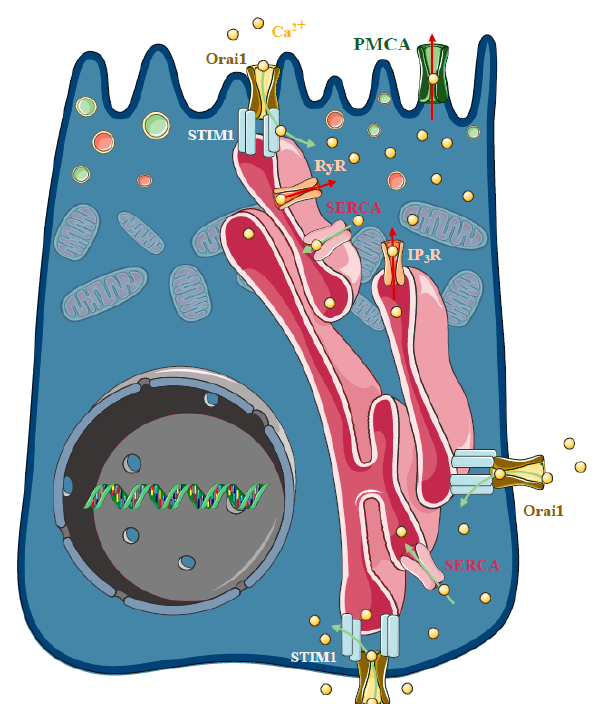
Figure 4. Store-operated Ca 2+ entry and acute pancreatitis. In pancreatic acinar cells physiological agonist stimulation releases Ca 2+ from the endoplasmic reticulum (ER) stores at the apical granular region of the cell. The spatiotemporal localisation of IP 3 -evoked apical signals is maintained by the mitochondria surrounding the apical region of the acinar cells, whereas the plasma membrane Ca 2+ ATPase (PMCA) pumps extrude the Ca 2+ at the apical membrane. The influx of extracellular Ca 2+ in non-excitable cells is mediated by a process called store-operated Ca 2+ entry (SOCE), which is determined by the ER Ca 2+ sensor stromal interaction molecule 1 (Stim1) and the plasma membrane Ca 2+ channel Orai1. In unstimulated cells, Stim1 is distributed in the ER membrane, whereas mobilisation of the ER Ca 2+ stores induces a conformational change and translocation with puncta formation, of Stim1 to the ER–PM junctions, which activates Orai1. The basal Ca 2+ uptake can refill the apical Ca 2+ stores by a mechanism called Ca 2+ tunnelling. Under pathological conditions, the spatiotemporal regulation of the Ca 2+ signalling fails and extracellular Ca 2+ entry is an important contributor to the Ca 2+ toxicity. Recently, an Orai1 channel regulator protein called store-operated calcium entry-associated regulatory factor (Saraf) was described as a crucial component in pathological Ca 2+ signal development. Saraf knockout mice developed more severe acute pancreatitis (AP) compared to controls accompanied by increased Ca 2+ influx in acinar cells, whereas Saraf overexpression reduced acinar Ca 2+ influx and decreased the severity of AP.